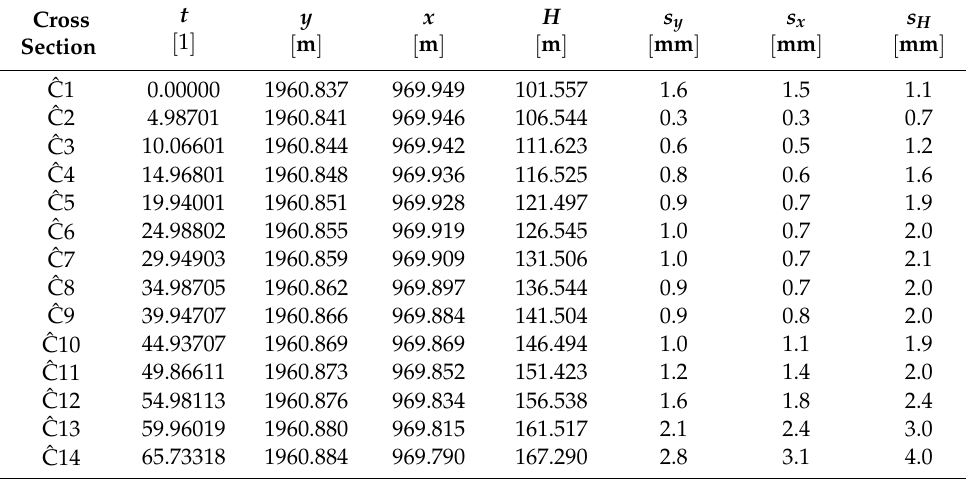
Table 11. Final regression results based on the reference TS data set; parameter t defines the position of the cross section along the quadratic cure and determines its 3D